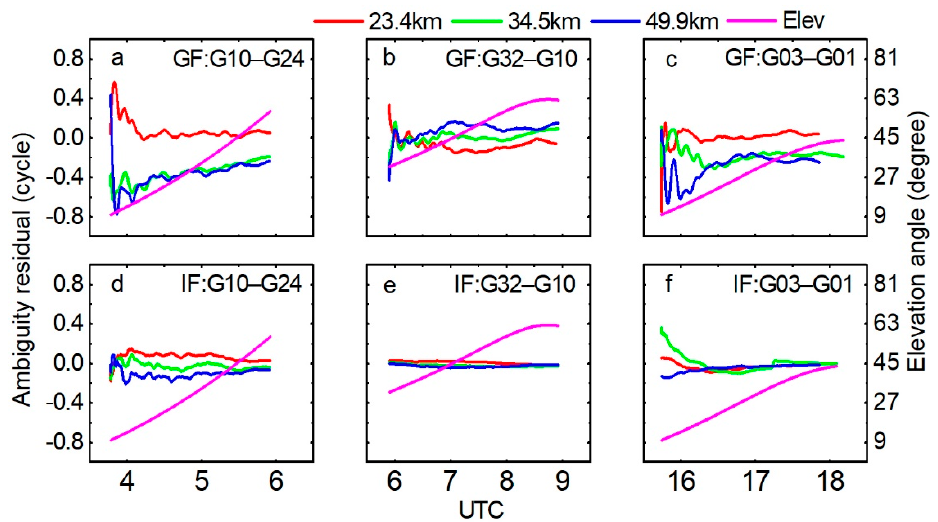
Figure 9. Ambiguity residual of L1 signal by GF TCAR method (upper row) and IF TCAR method